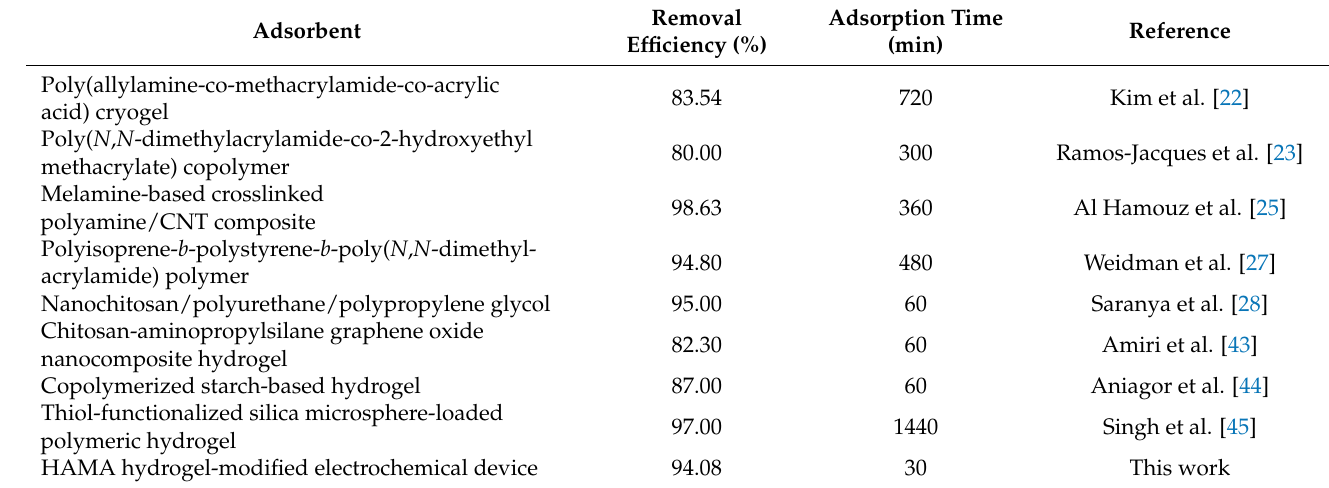
Figure 8. Comparison of adsorption efficiency for the HAMA hydrogel-modified devices without (blue dots) and with (red dots) electrochemical accumulation. Data obtained using three devices. Table 2. Comparison of Pb(II) removal efficiency of different